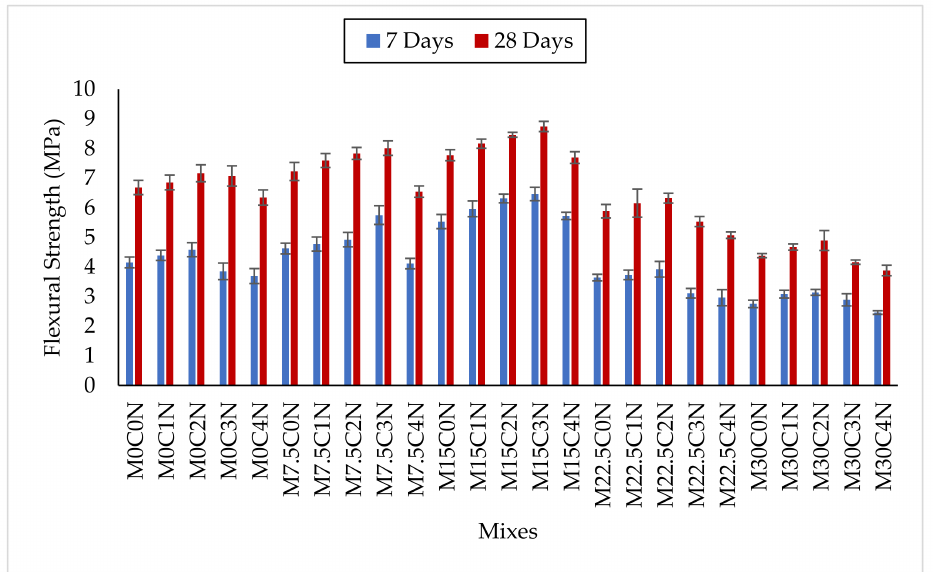
Figure 10. Flexural Strength